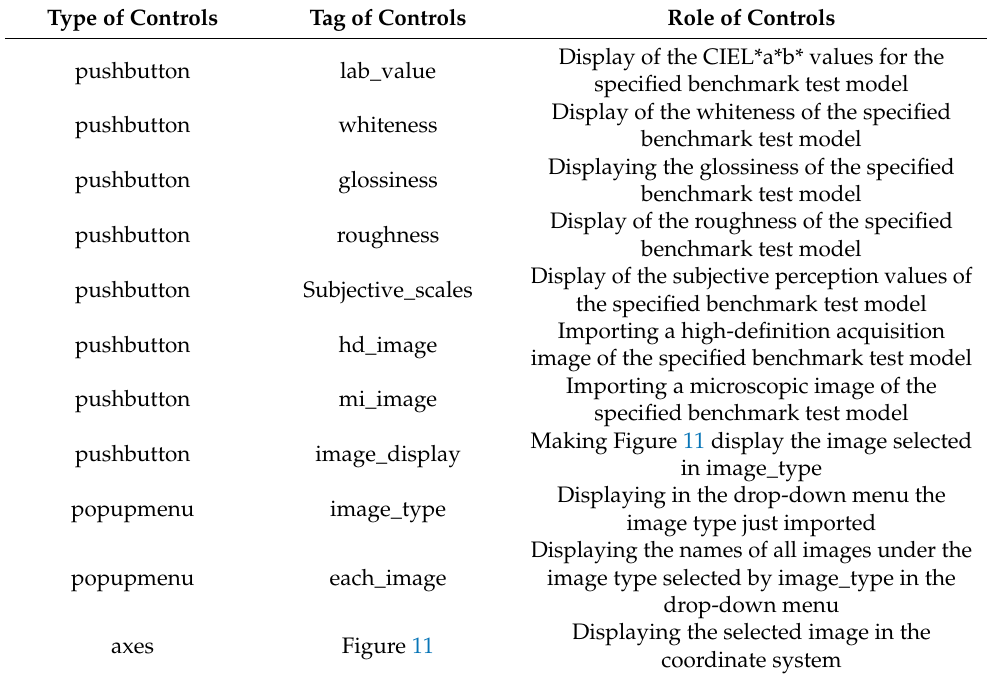
Figure 11 Displaying the selected image in the coordinate system